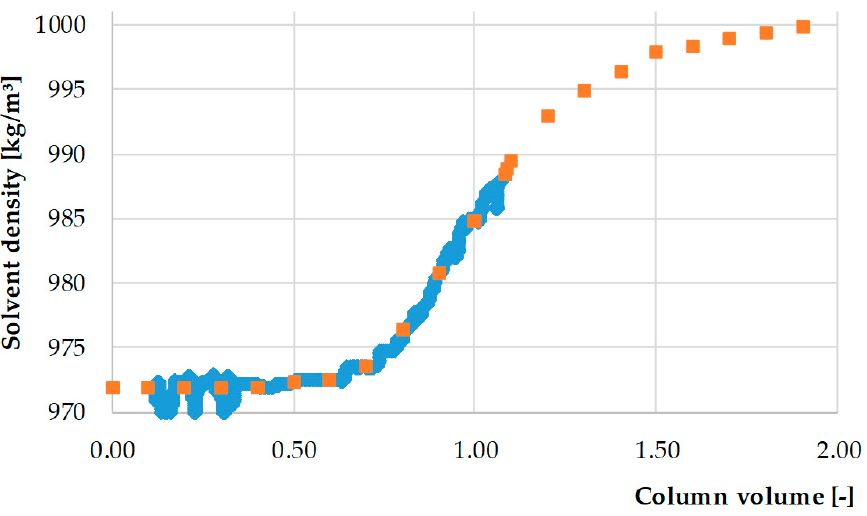
Figure 10. Step function of the production equipment.